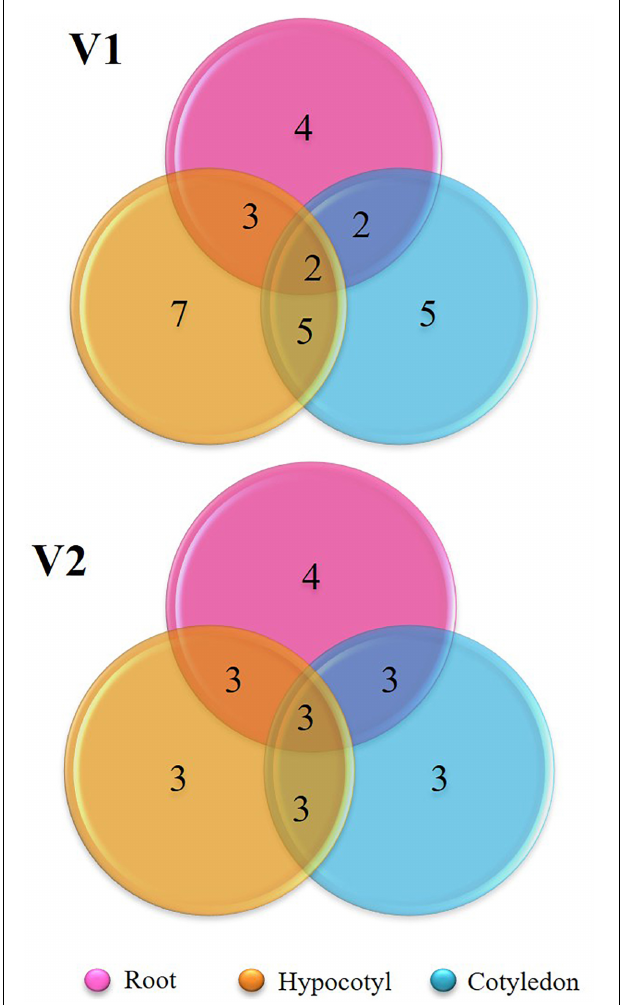
FIGURE 3 | Venn diagram representing the shared species of isolated bacterial endophytes within the